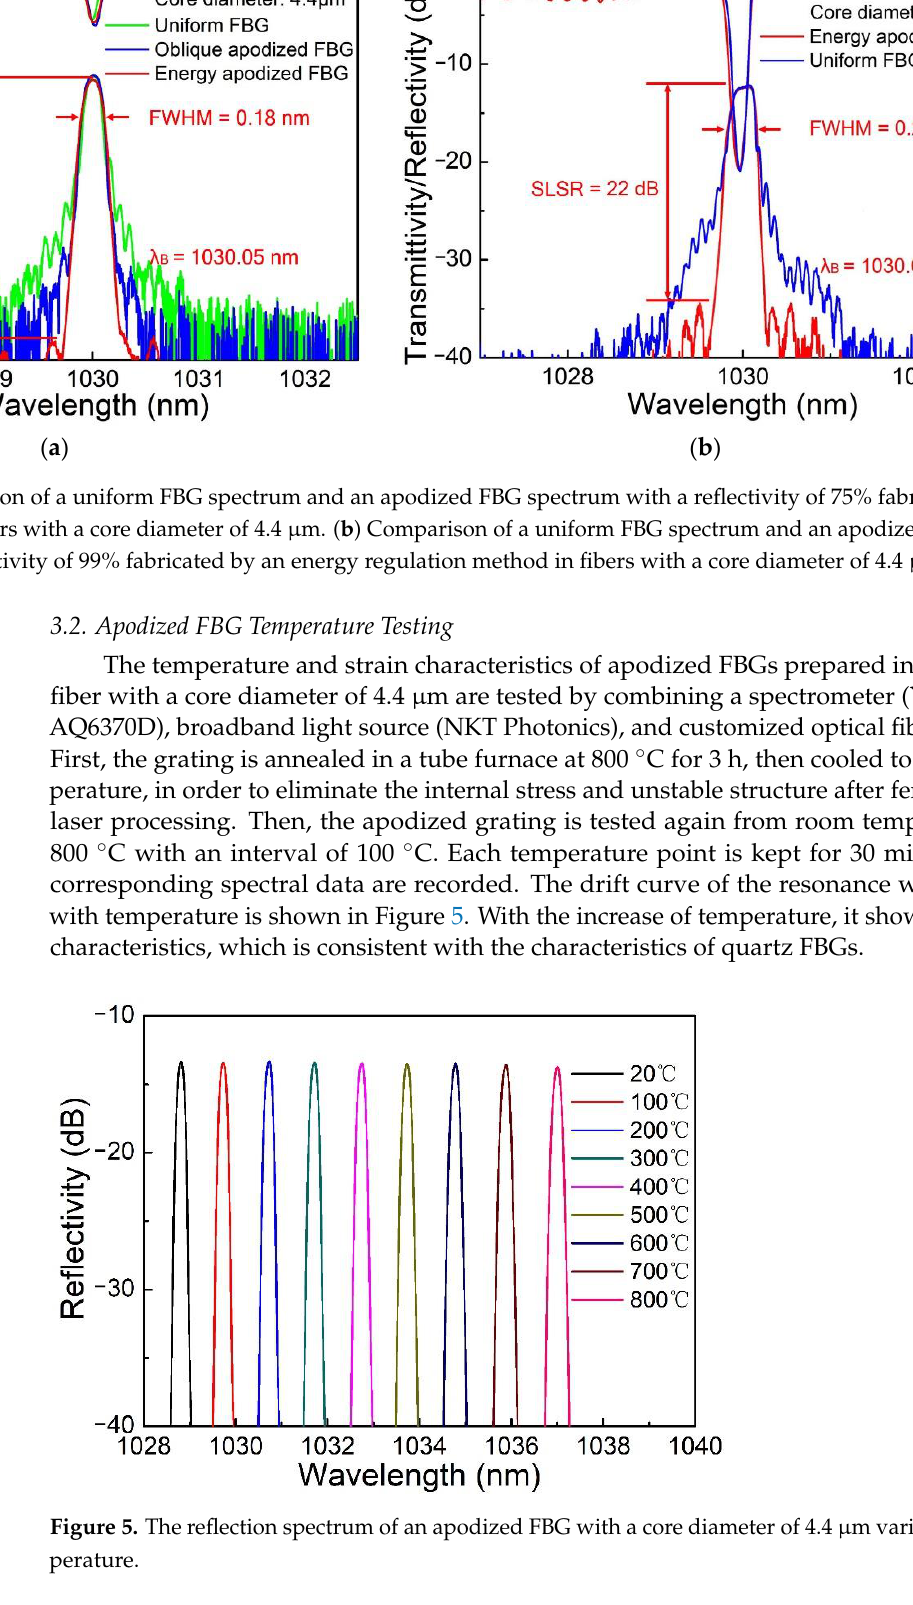
Figure 3. ( a ) Comparison of a uniform FBG spectrum and an apodized FBG spectrum with a reflectivity of 75% fabricated by two methods in fibers with a core diameter of 9 μm. ( b ) Comparison of a uniform FBG spectrum and an apodized FBG spectrum with a reflectivity of 99% fabricated by an energy regulation method in fibers with a core diameter of 9 μm. Compared with a standard single-mode fiber, a thin core fiber has a smaller cut-off wavelength and can support shorter-wavelength light to realize single-mode transmis- sion, so it has a good application value in short-wavelength laser. However, the core di- ameter of a thin core fiber is small, so it is more challenging to prepare apodized FBGs with different parameters. FBGs have important applications in fiber lasers [27,28], and the wavelength of 1030 nm is a common laser wavelength. As shown in Figure 4a, three